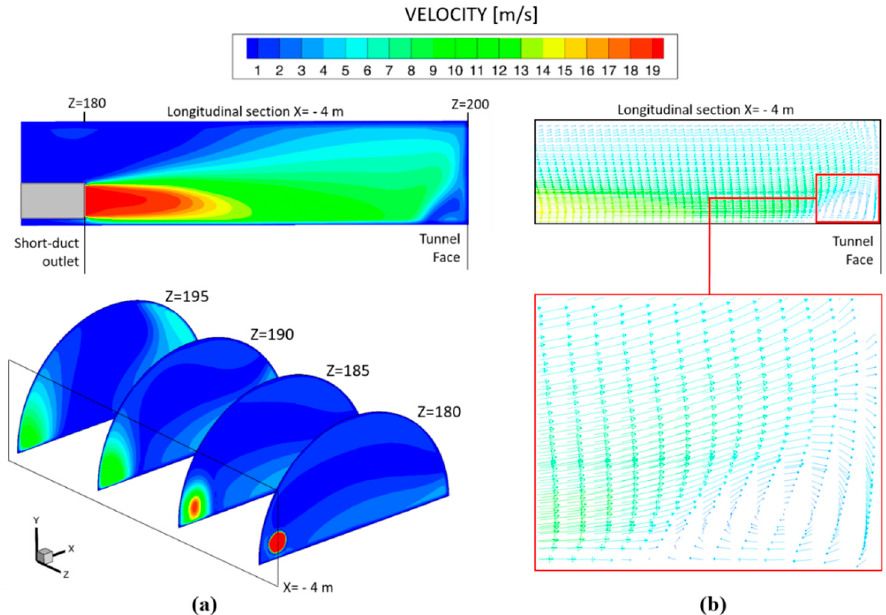
Figure 20. Mixed ventilation system: ( a ) blower jet at the outlet of the short-forced duct at the longitudinal section (X = − 4 m) and cross sections of Z = 180, Z = 185, Z = 190 and Z = 195 m, and ( b ) velocity vectors and details of the vortex zone at the longitudinal section of X = − 4 m after impacting the tunnel face.